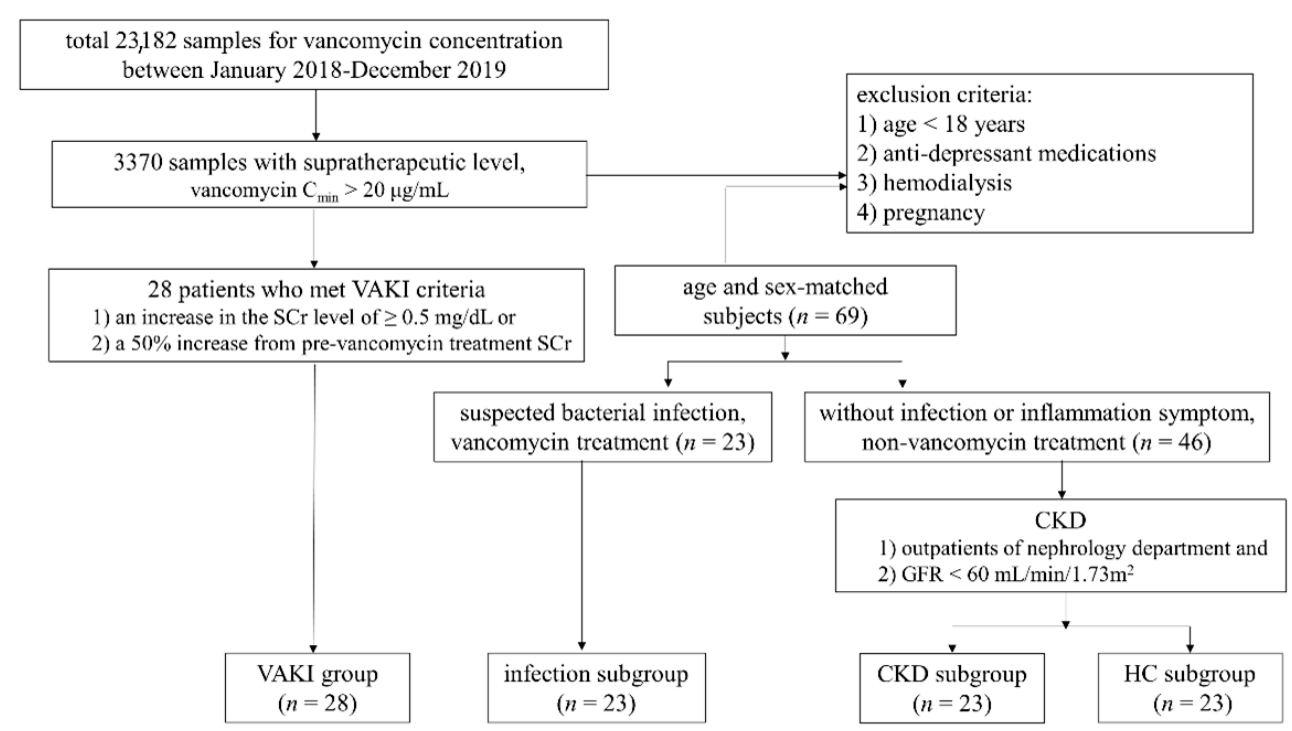
Figure 1. Schematic study flow and cohort population. Abbreviations: VAKI, vancomycin-associated acute kidney injury; CKD, chronic kidney disease; HC, healthy control; C min , trough concentration; GFR, glomerular filtration rate; SCr, serum creatinine